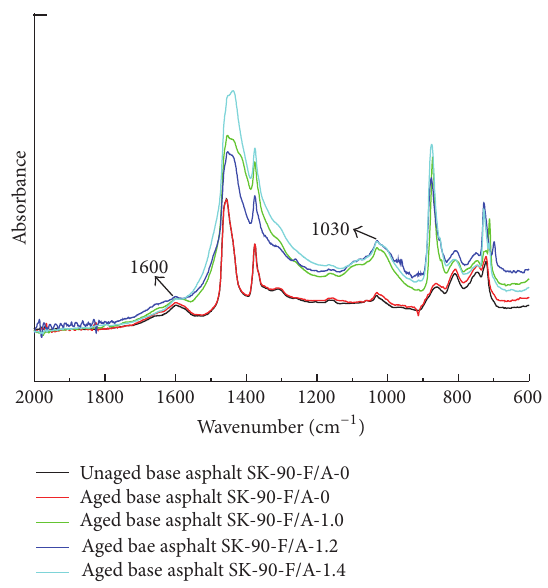
Figure 2: FTIR spectra of base asphalt mortar.